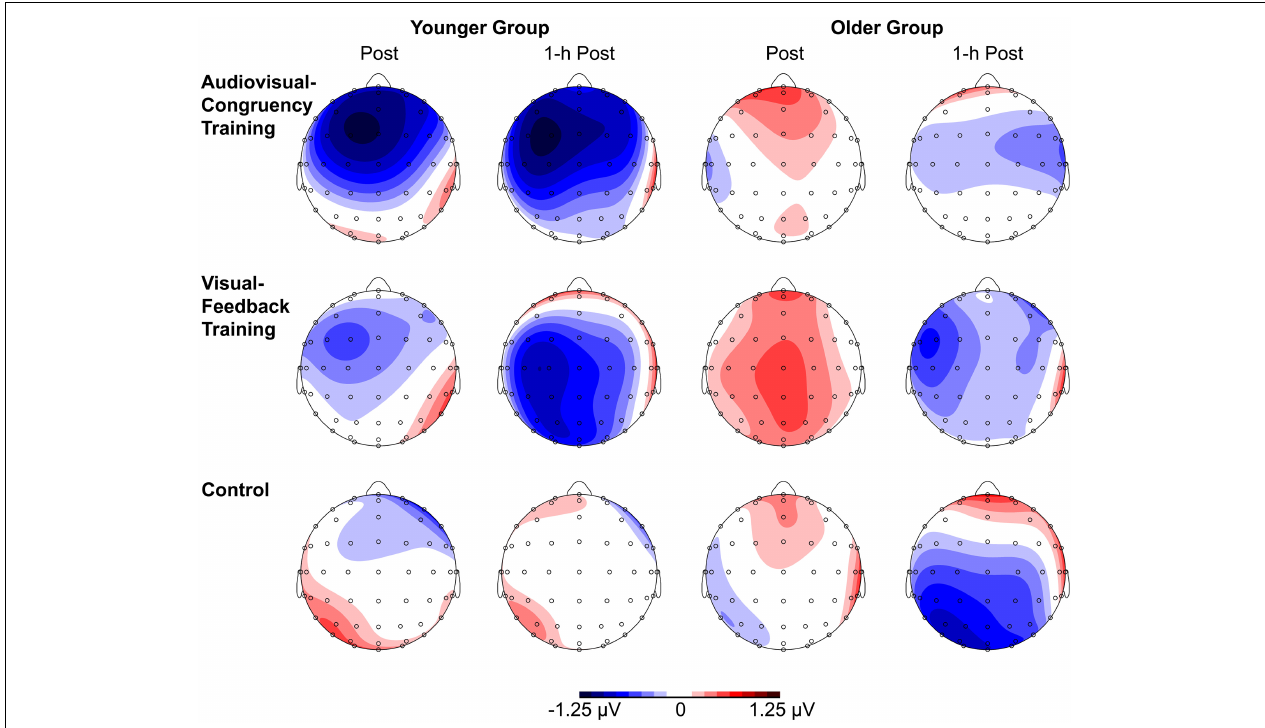
FIGURE 4 | Topographies of N2 components. Baseline-normalized topographies, assessed immediately after (post) and 1 h after training (1-h post) in younger and older participants are shown separately for audiovisual-congruency training, visual-feedback training, and control condition.